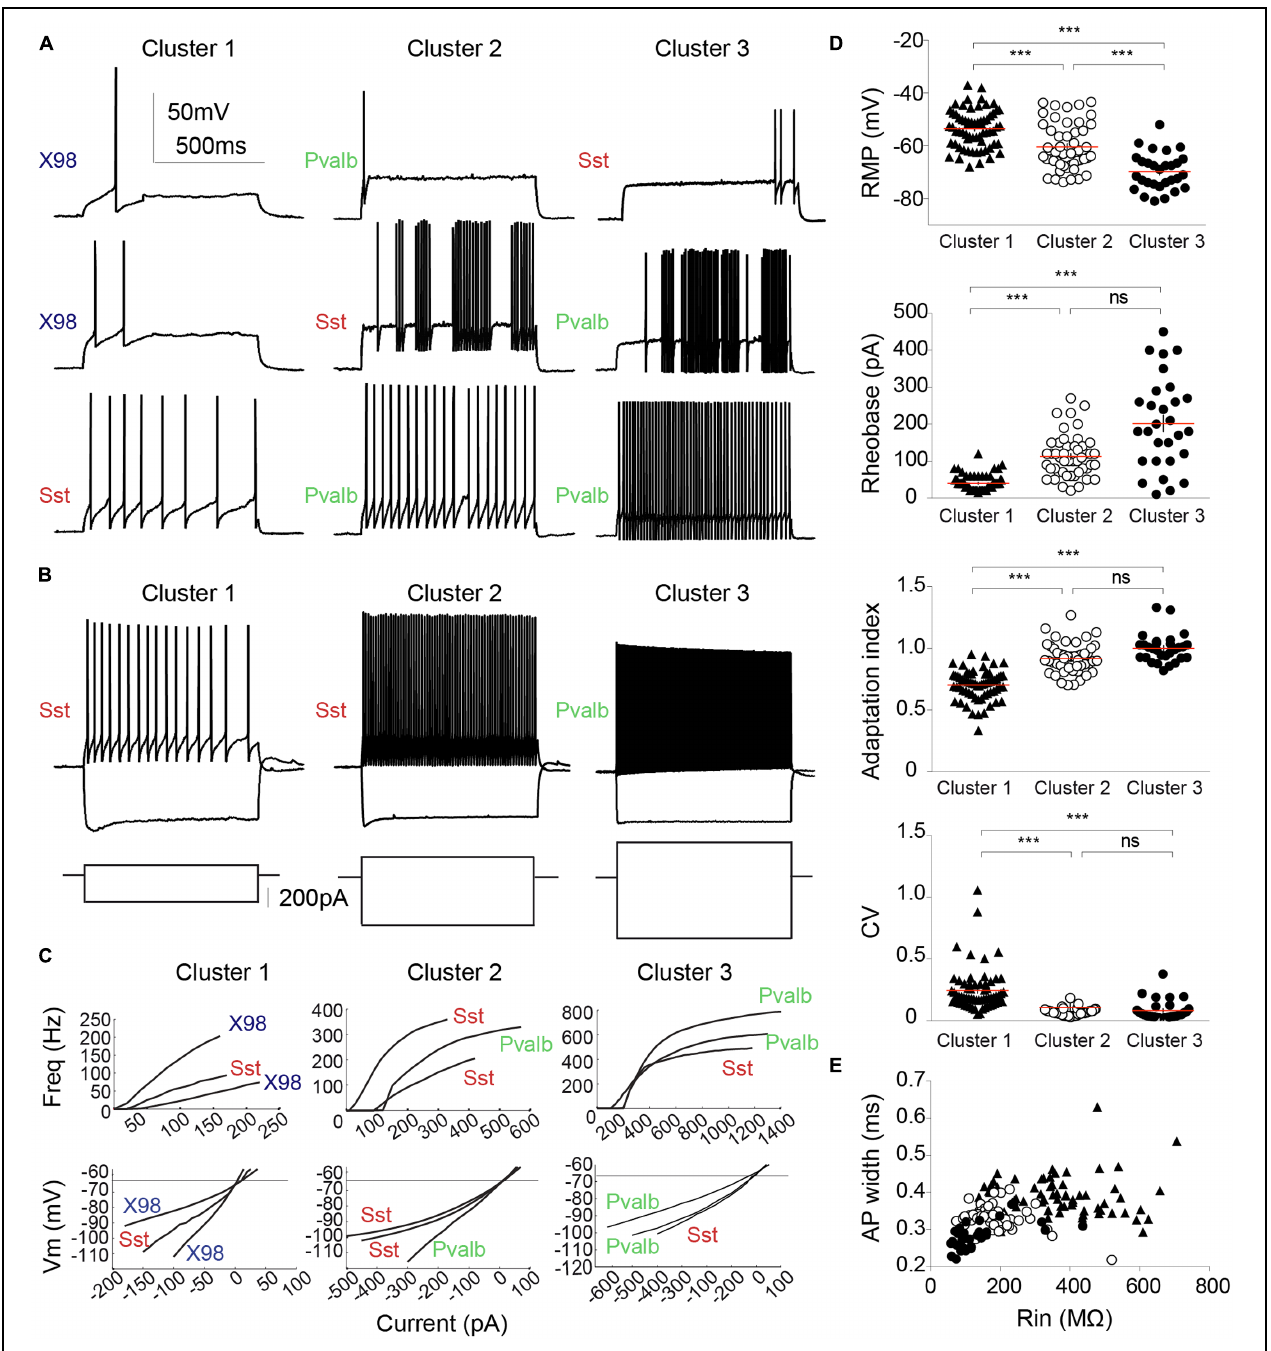
FIGURE 6 | Electrophysiological diversity of PV or SOM expressing interneurons. (A) Examples of firing patterns of three different interneurons from each cluster in response to a 800 ms rheobase current pulse. (B) Firing induced by a twice rheobase depolarizing current and the trajectory of hyperpolarization to − 100 mV induced by a negative current pulse. Note the low R in of neurons in cluster 1 compared with that of neurons in clusters 2 and 3 (larger current steps are needed to elicit similar voltage changes). Most pronounced voltage sags in response to hyperpolarization were exhibited by neurons of cluster 1 . (C) Input–output curves (upper) and current–voltage relations at sub-threshold potentials (lower) are plotted for